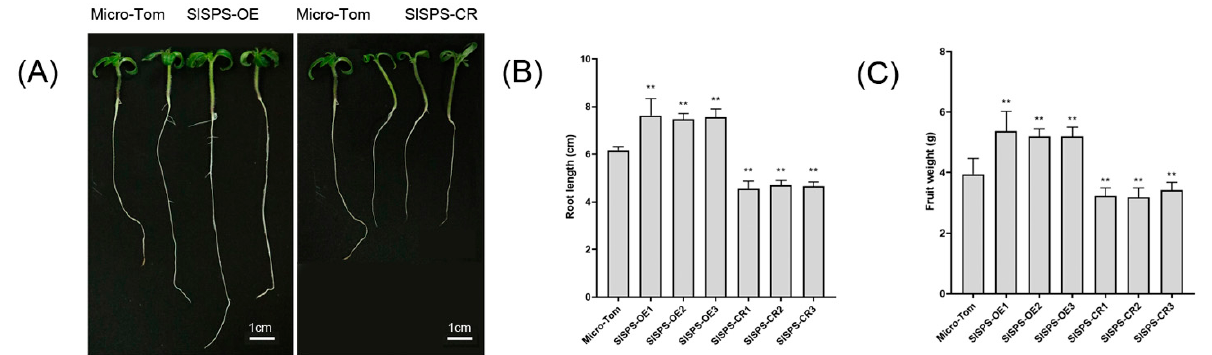
Figure 3. Root length ( A , B ) and fruit weight ( C ) in transgenic lines and Micro-Tom plants. Root length and fruit weight were analyzed at 2-week and 12-week seedling stage (n = 20 for each line). Values in ( B , C ) are means ± SD. ** p < 0.01, comparisons with the Micro-Tom plants using Student’s t -tests.